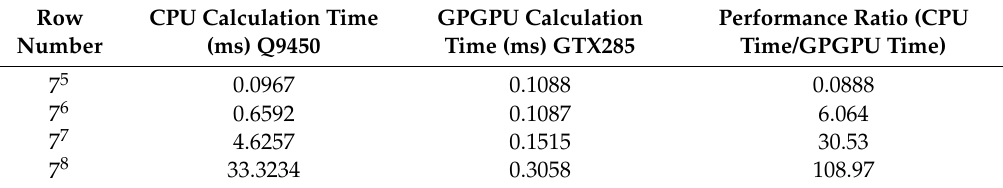
Table 4. Performance ratio of